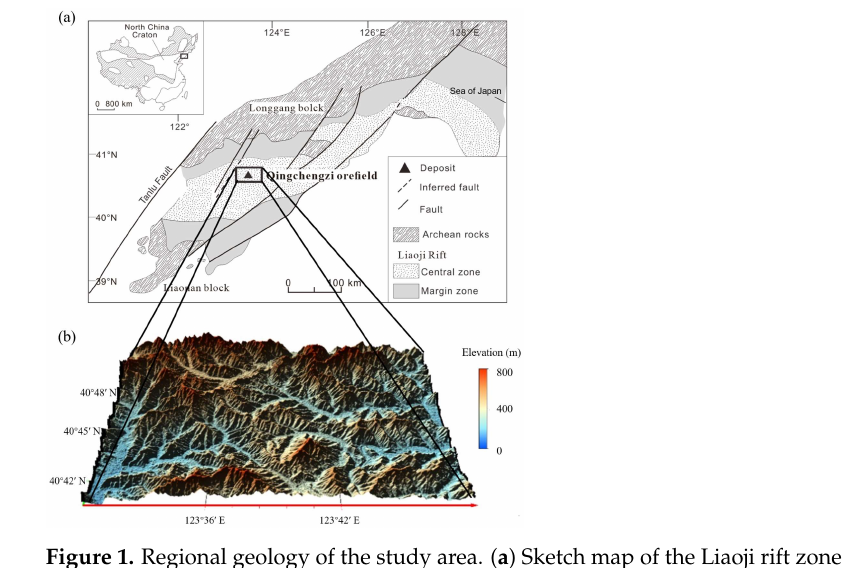
Figure 1. Regional geology of the study area. ( a ) Sketch map of the Liaoji rift zone and location of the Qingchengzi ore field (modified after Wang and Qu, 2000). ( b ) Topographic map of Qingchengzi ore concentration area.